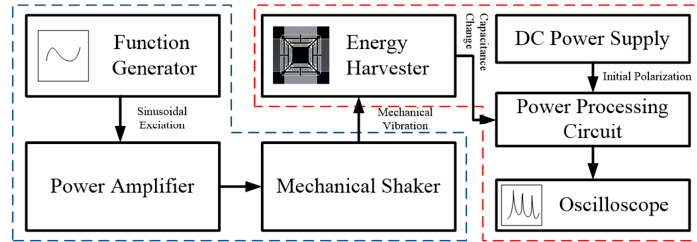
Figure 5. Experimental setup. The blue dotted line indicates the equipment setup for generating the mechanical vibration, whereas the red dotted line indicates the equipment setup for reading the generated voltage.